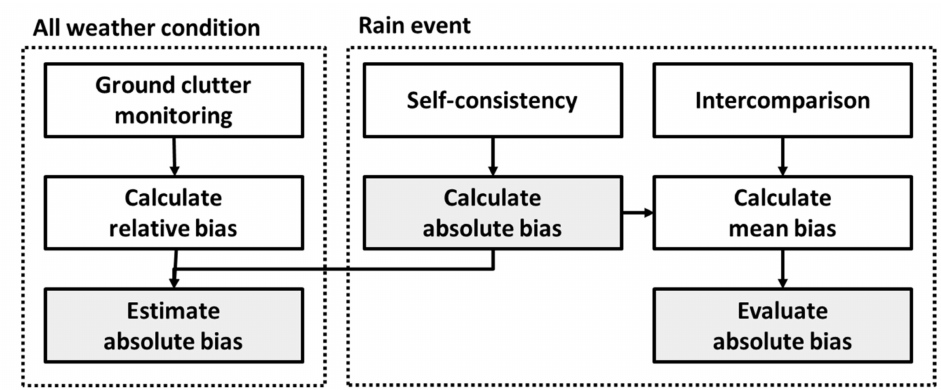
Figure 2. Concepts of calculating and monitoring of calibration bias in the Z H measurements in real